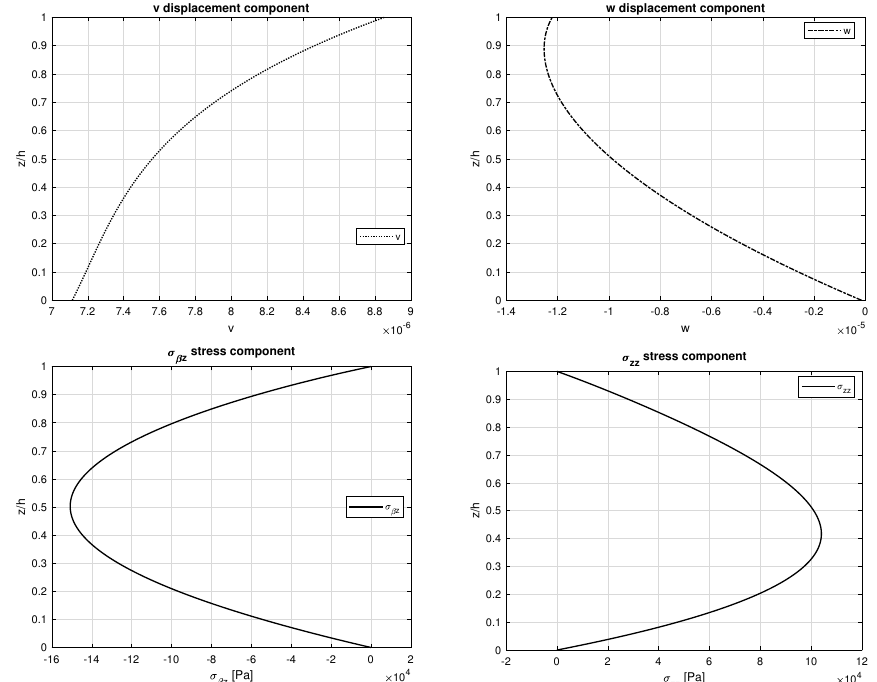
Figure 13. Fourth benchmark, displacements and stresses for a thick ( R α / h = 10) simply supported spherical shell with one FGM ( p = 2) layer obtained using the 3D-u- θ model. Maximum amplitudes: w and σ zz at ( a /2, b /2); v and σ β z at ( a /2,0). Table 6. Fourth benchmark, simply supported spherical shell with one FGM ( p = 2) layer. Sovra- temperature imposed as Θ t = 0 K and Θ b = − 1 K for m = 2 and n = 1. 3D uncoupled thermoelastic models from [70]. The new 3D coupled thermoelastic solution is 3D-u- θ . R α /h 2